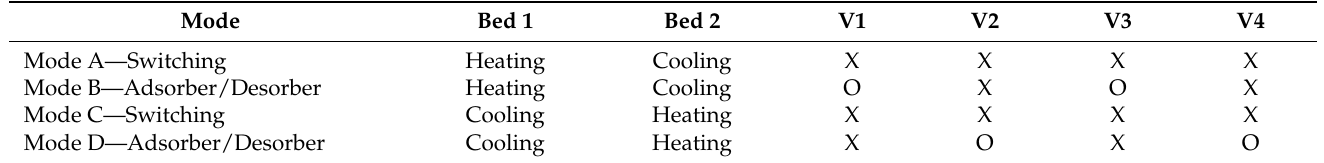
Table 2. Two-bed operation in the adsorption system (X = closed, O = open).